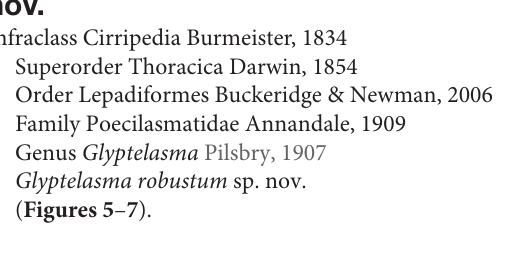
attaching to the mantle of the female. In general, the filamentary appendage is absent from the Arcoscalpellum species even from the scalpellid species (Zevina, 1981b). However, the current species has two pairs of angular processes on the dorsum of the thoracic body; this kind of process is only reported in Litoscalpellum spinosus (Chan et al., 2010). In contrast, nearly all Arcoscalpellum species have a single- or multi-segment caudal appendage (Zevina, 1978). Even if it is vestigial, some trace should be observed, such as Arcoscalpellum ciliatum and Arcoscalpellum gryllum , but no vestigial trace was observed in the present species under the